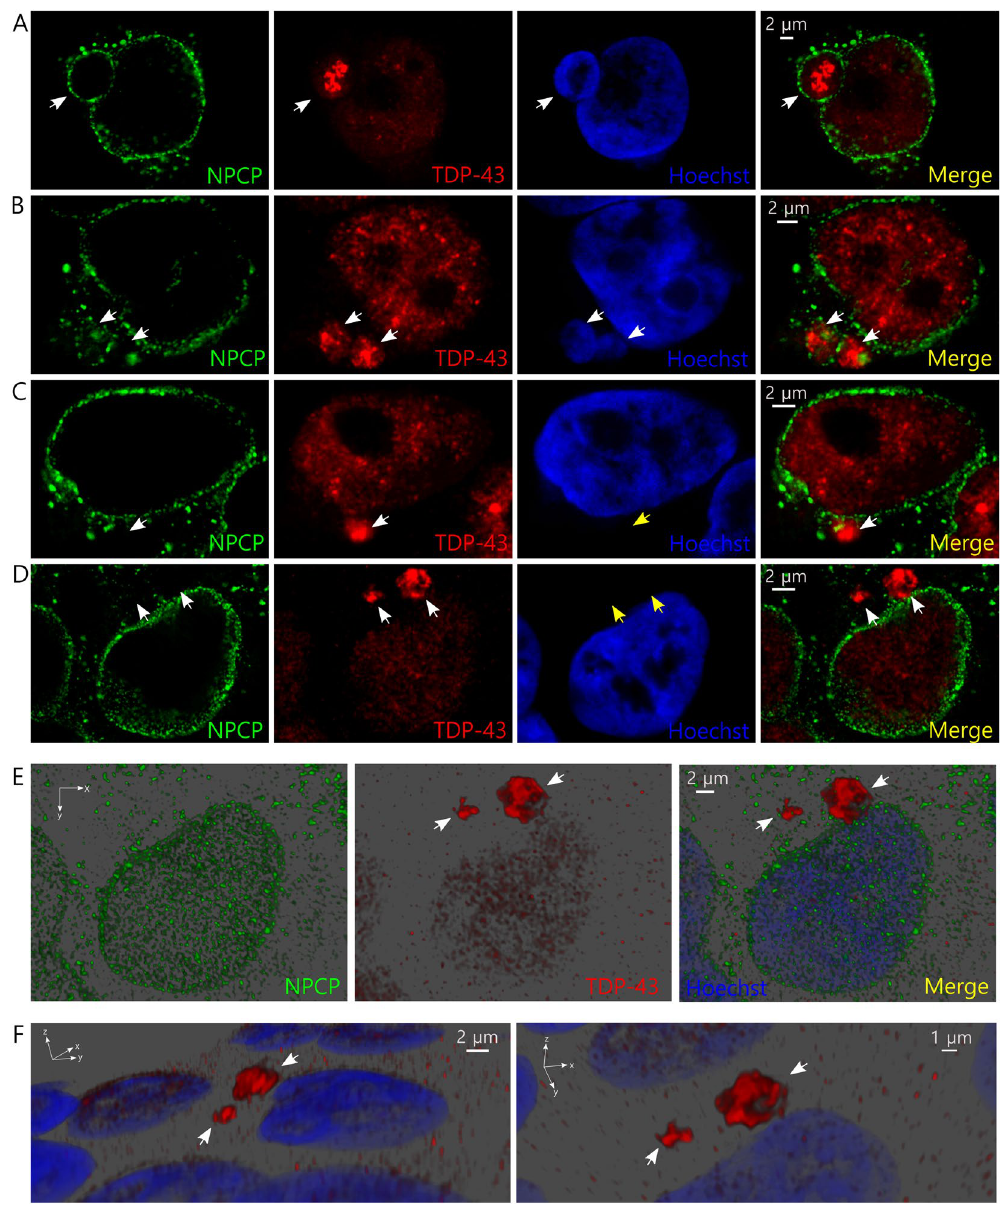
stress in HEK293T cells: intact micronucleus (continuous) ( A ), partial disruption (discontinuous) ( B ), absence of nuclear membrane proteins and detectable nucleic acids (collapsed) ( C ), and collapsed micronucleus with observation of massive cytoplasmic aggregates ( D ). Micronuclei containing TDP-43 aggregates are indicated by white arrows. Absence of nucleic acids in ( C ) and ( D ) is indicated by yellow arrows. ( E , F ) 3D reconstruction from confocal set of images of the cell presented in D showing the massive cytoplasmic aggregate formed after lactate-induced metabolic stress. ( E ) Shows the xy axis and ( F ) shows to different xyz angles that allows detailed observation of the aggregates (white arrows) shape and their position relative to the